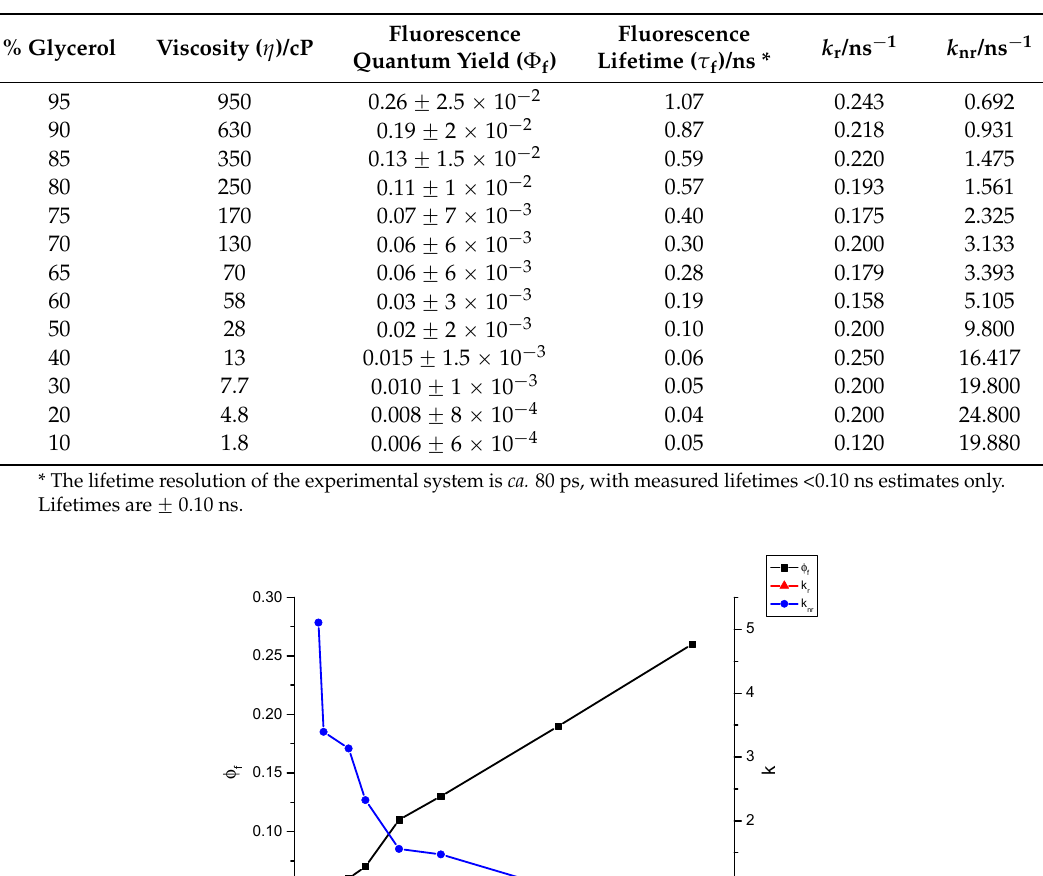
Table 2. Fluorescence quantum yield ( φ f ), fluorescence lifetime ( τ f ) *, radiative ( k r ) and non-radiative ( k nr ) rate constants of dU-BZ as a function of viscosities ( η ) in glycerol/methanol solutions. % Glycerol